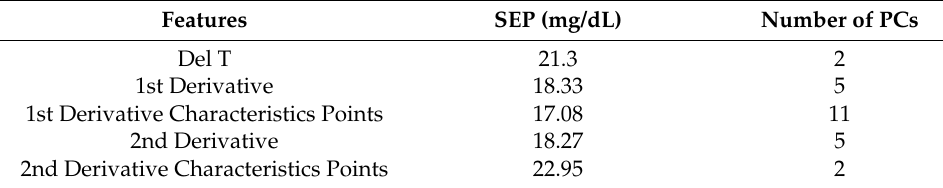
Table 2. Comparison of performances of different PCR